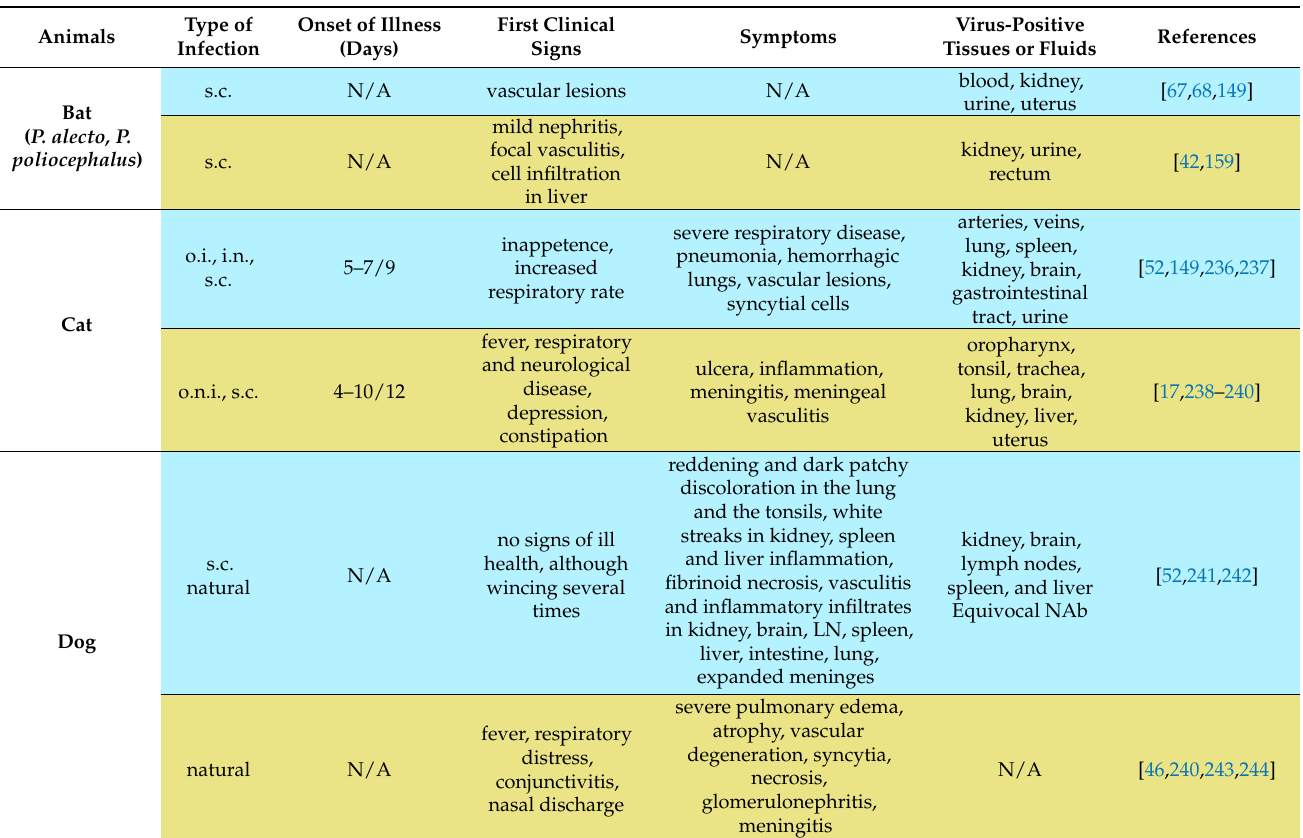
Table 1. Animal models of HeV and NiV